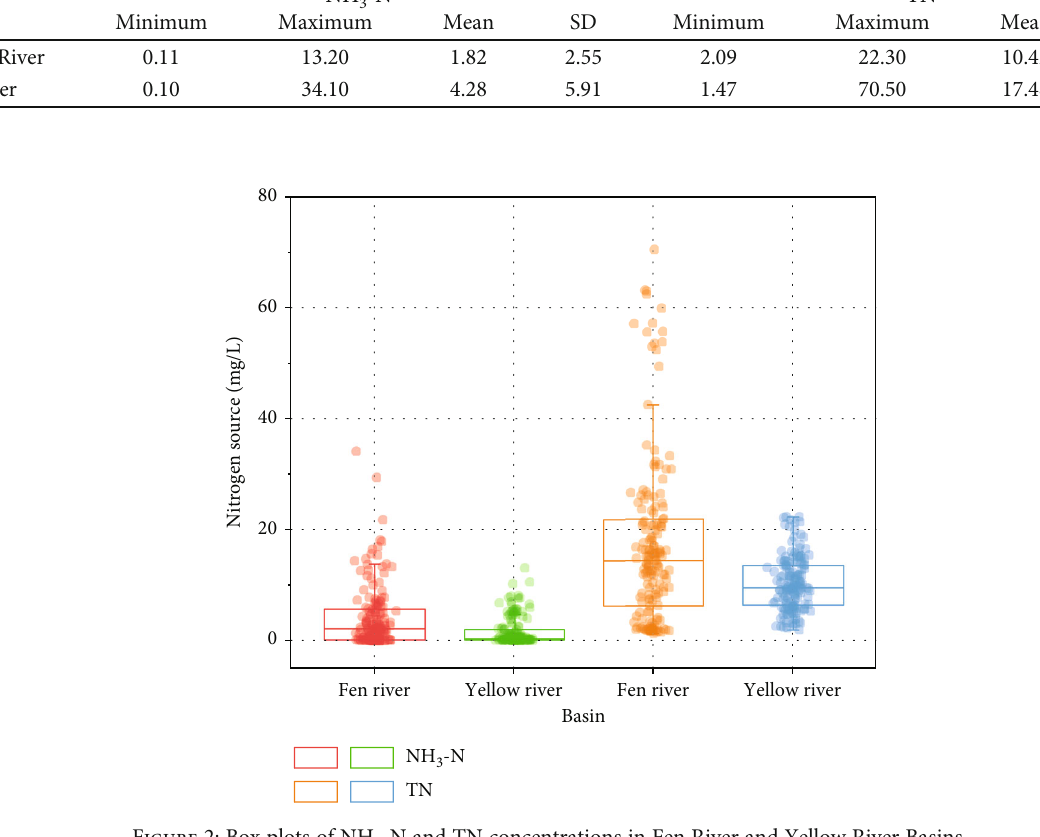
Figure 2: Box plots of NH -N and TN concentrations in Fen River and Yellow River Basins. 3 Table 2: Seasonal variations of the nitrogen concentrations in Yellow River and Fen River